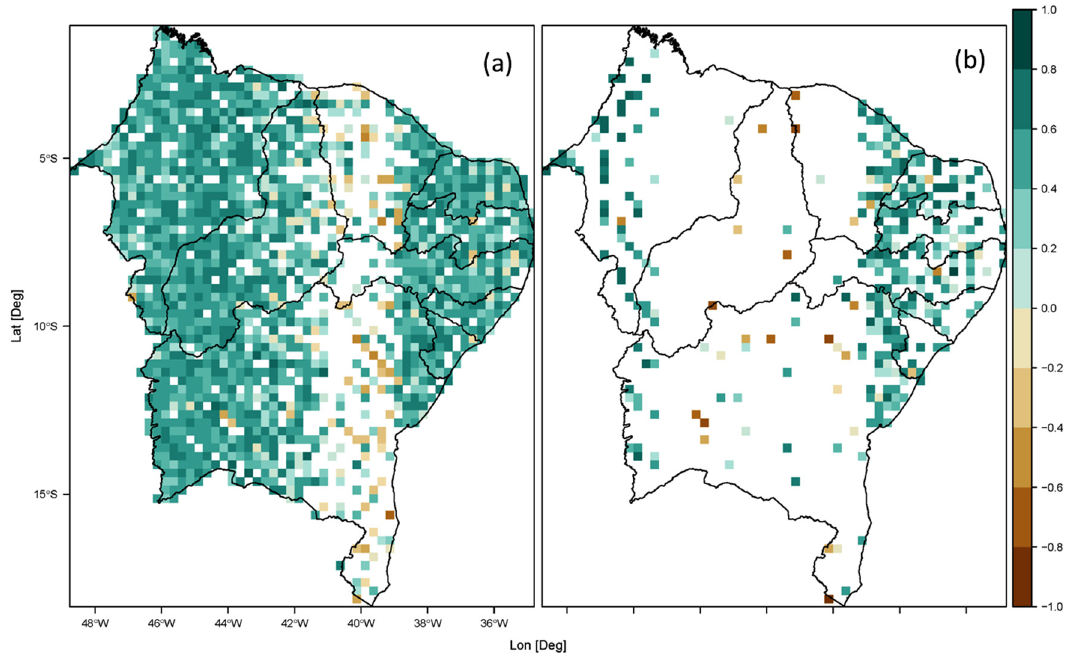
Figure 3. Spatial distribution of Pearson’s correlation coefficients between the AWD and SWDIS from June 2010 to December 2013 for: ( a ) the entire year; and ( b ) the growing season. Whited cells depict gaps or omitted values.